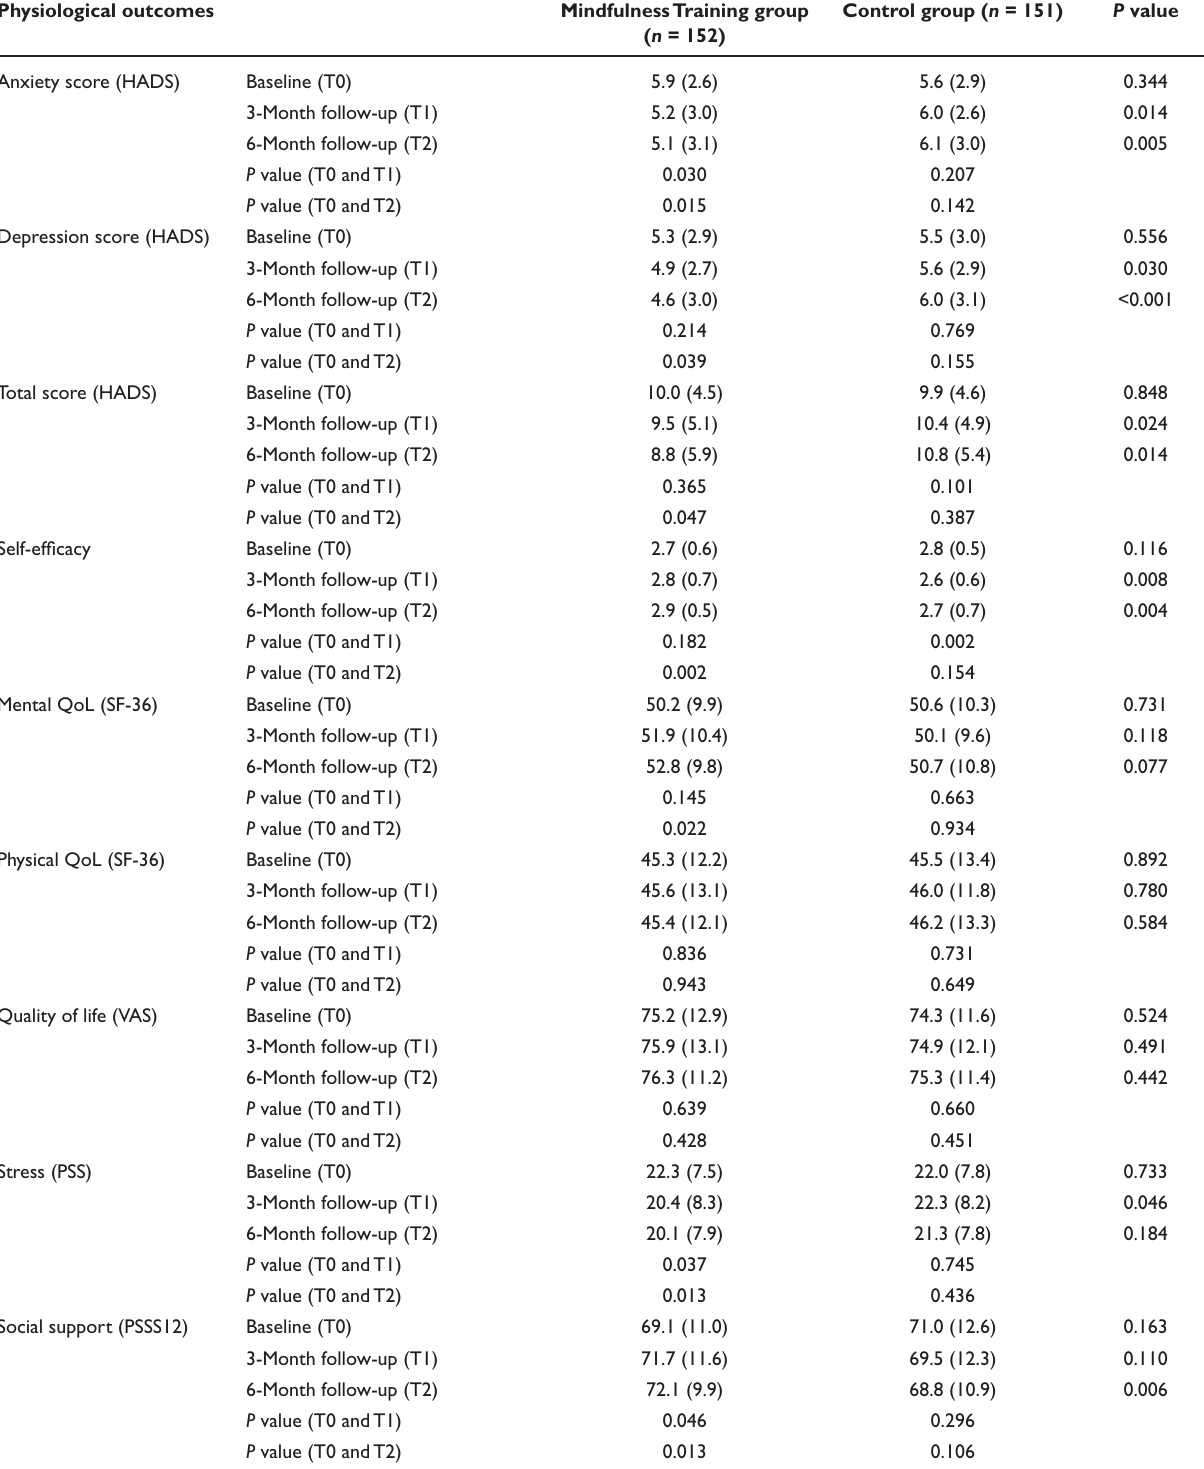
Table 3 . Changes in psychological outcomes over time Physiological outcomes Mindfulness Training group